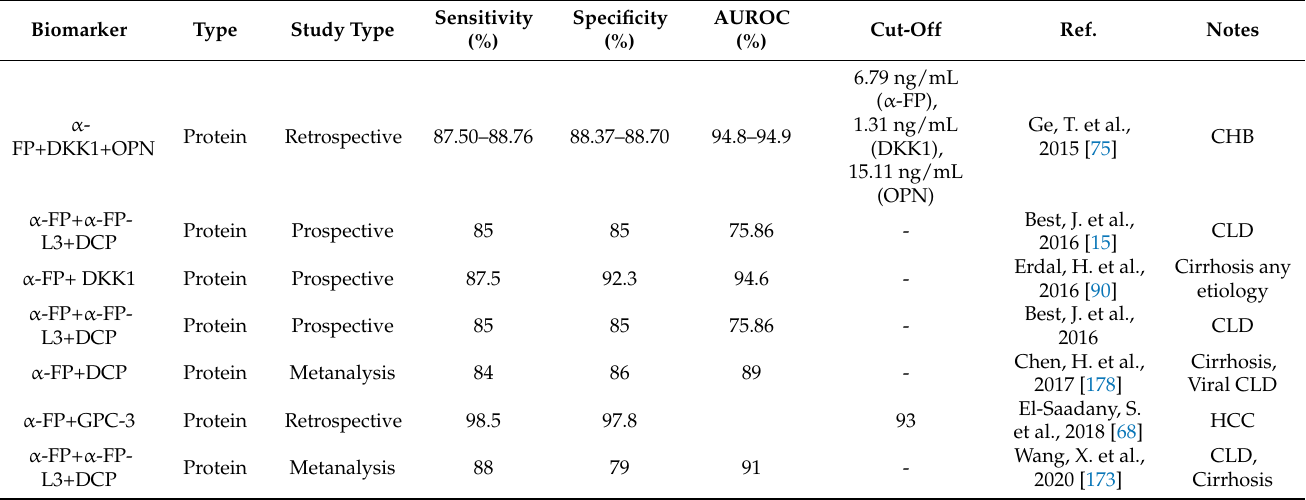
Table 2. Example of combinations of HCC diagnostic biomarkers. Sensitivity, specificity and AUROC shown as percentages